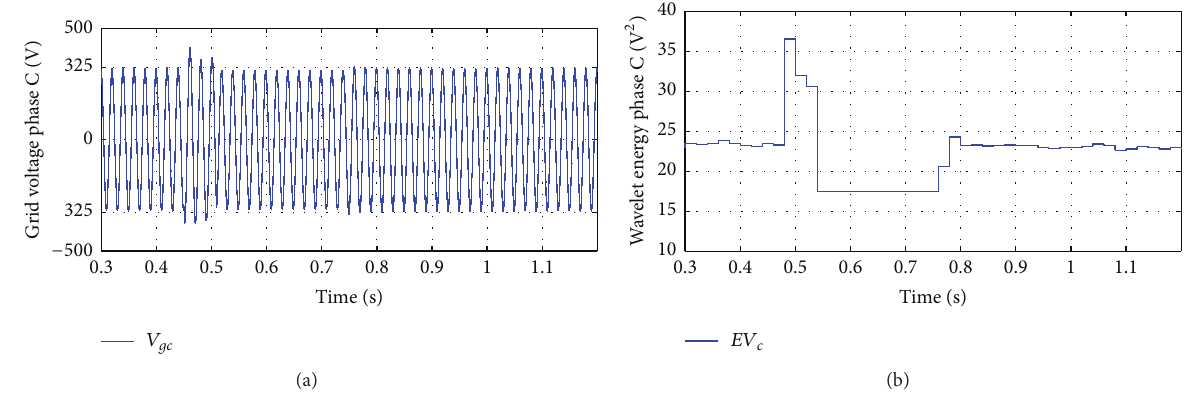
Figure 15: (a) Voltage signal and (b) corresponding wavelet energy plot of phase